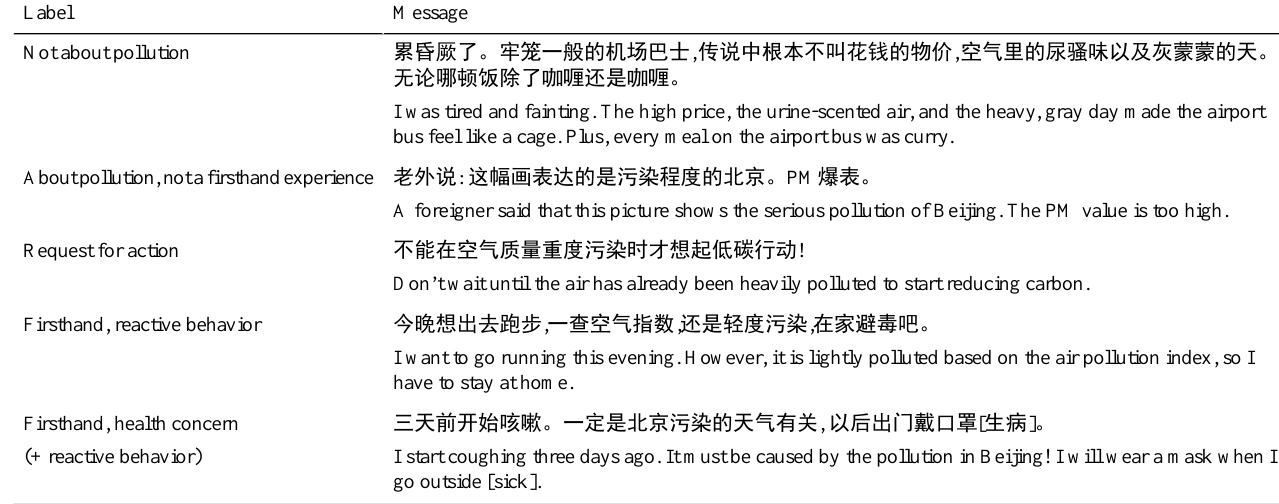
Table 3. Examples of messages with various labels (the original Chinese Weibo is shown, followed by an English translation).